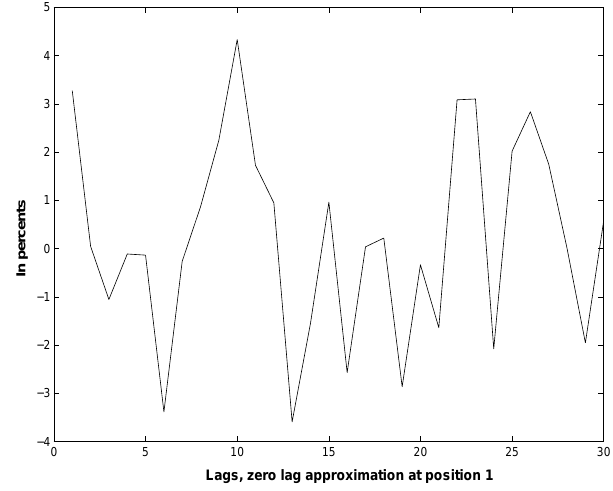
Fig. 5. Sums of the spatial ambiguities as a function of the lag in the D-layer part of the experiment, given in percents relative to the main